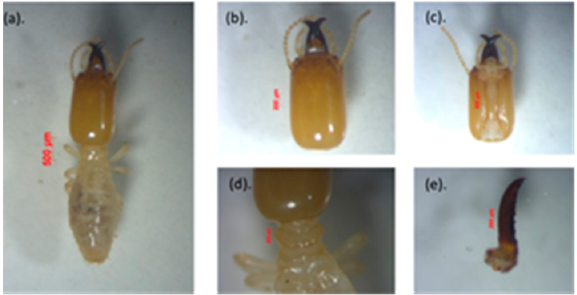
Figure 5. View of Microcerotermes serrula : ( a ) individual body shape of the soldier, ( b ) head with antennas, ( c ) postmentum, ( d ) pronotum, and ( e ) left mandible.